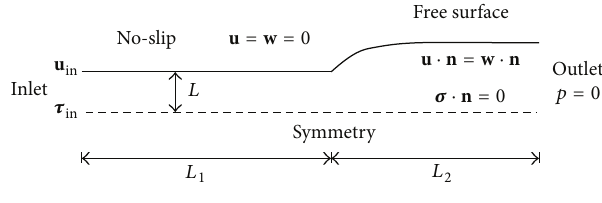
Figure 1: Die-swell flow